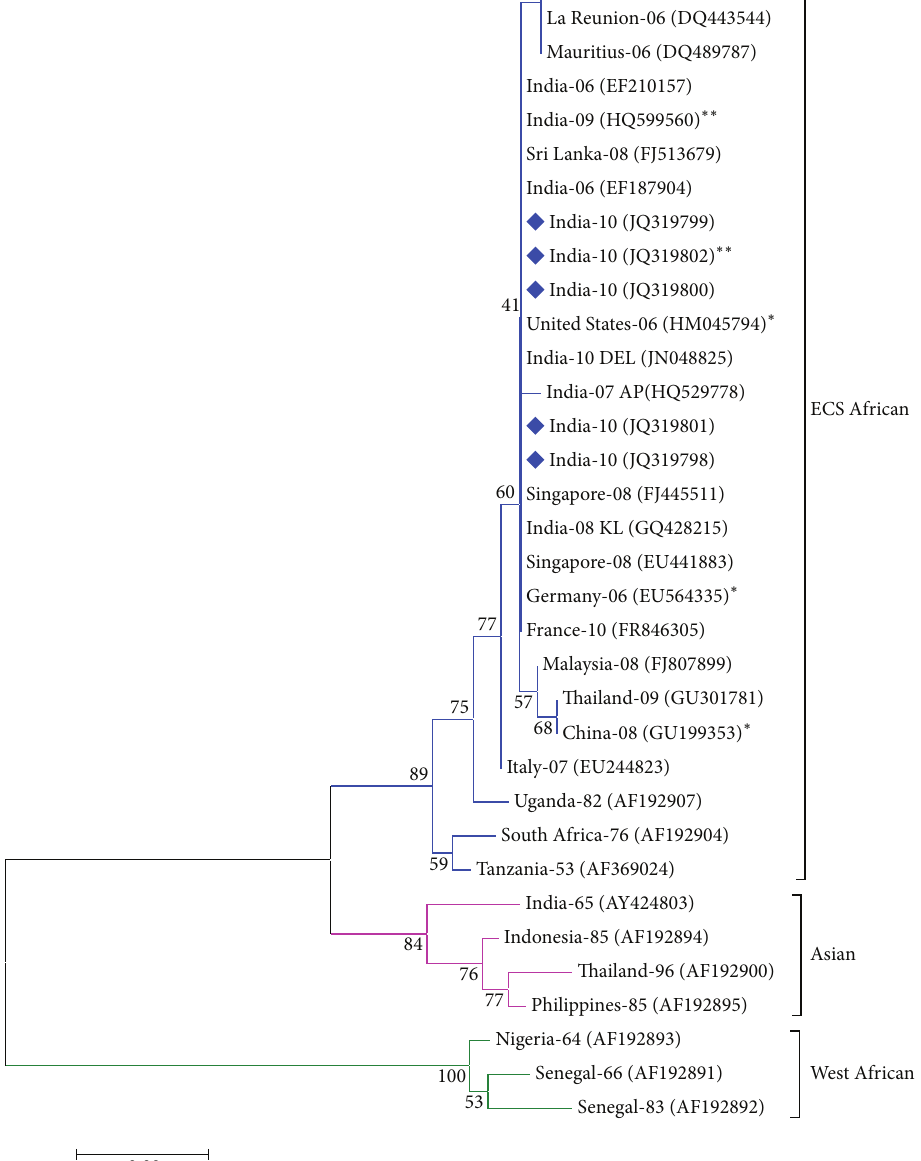
Figure 2: Phylogenetic tree among CHIK viruses generated by neighbor-joining method based on the partial nucleotide sequence of E1 gene. Each strain is abbreviated with the country of origin and last two digits of the year of isolation, followed by GenBank accession number in parenthesis (). The CHIKV sequenced in this study are marked with solid diamond ( X ). Bootstrap values are indicated at the major branch points. ∗ indicates the sequence of CHIKV from imported cases and ∗∗ indicates the sequences of CHIKV isolated from mosquito hosts.